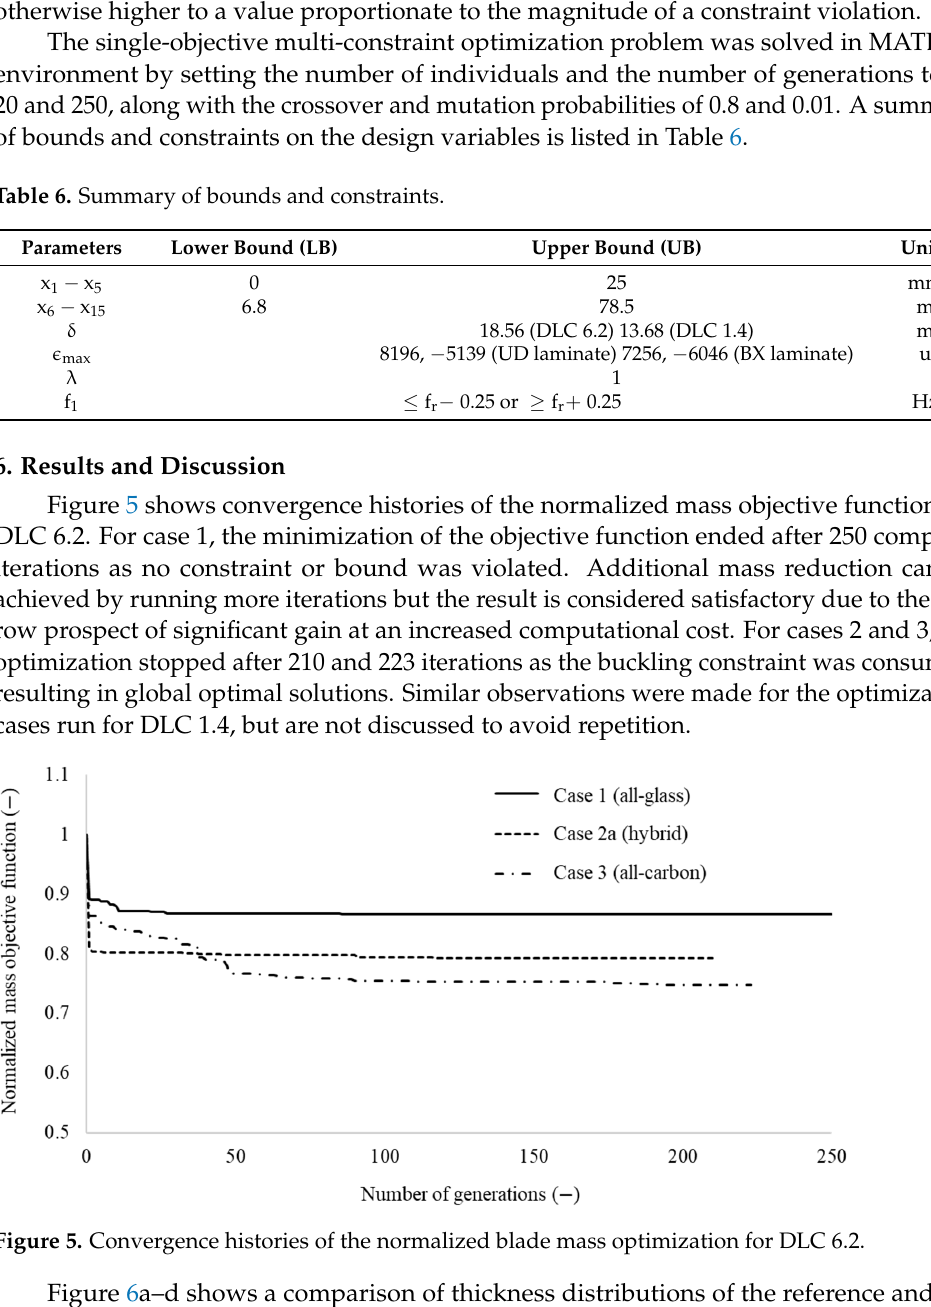
Figure 6. Thickness distributions of the optimized spars: ( a ) case 1, ( b , c ) case 2a–b and ( d ) case 3. Table 7 shows a summary of the design constraints at end of optimization. The tip deflection constraint was violated for case 1 for DLC 1.4 as it governs the design optimi- zation of the all-glass spars. The strength constraint remained always below the allowable limits. The buckling constraint was fully consumed for cases 2 and 3 as a substantial re-